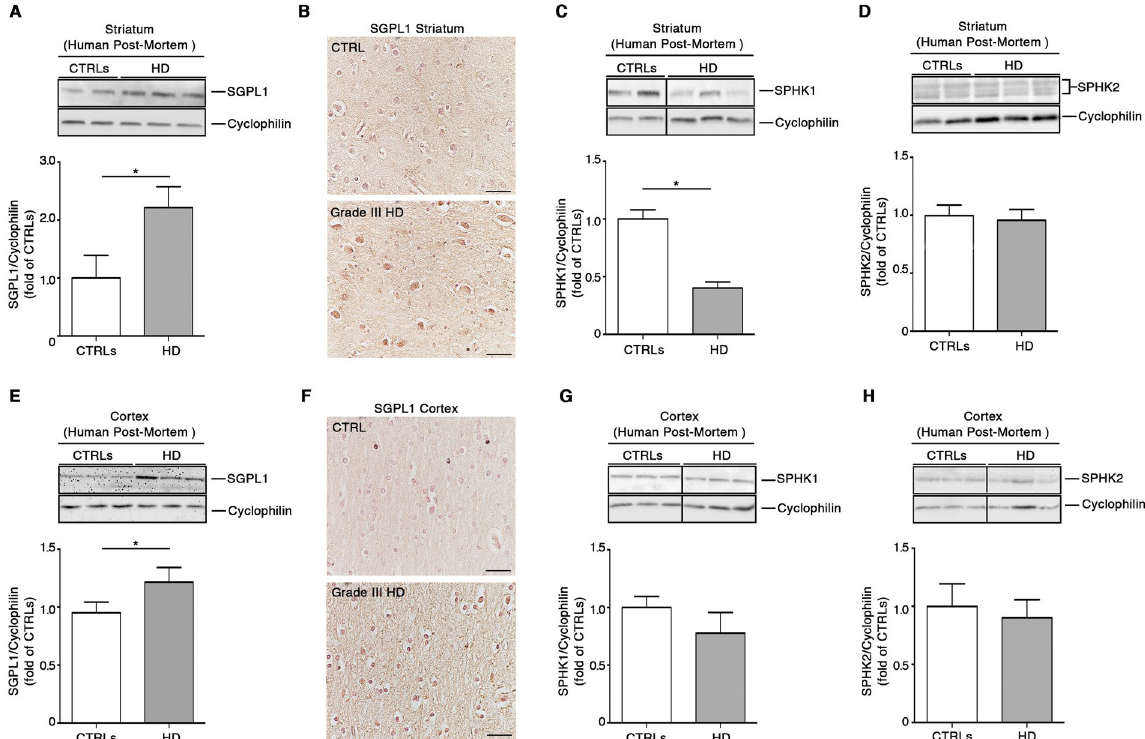
Figure 2. Expression of S1P metabolizing enzymes is abnormal in post-mortem brain tissues from HD patients. Cropped immunoblottings and densitometric analysis ( A ) along with representative immunohistochemical micrographs ( B ) of SGPL1 expression in the striatum from post-mortem human brains of manifest HD patients and age- and gender-matched healthy controls (see Table 1). Cropped immunoblottings and densitometric analysis of SPHK1( C ) and SPHK2 isoform expression ( D ) in the striatum from post-mortem human brains of the same subjects. Cropped immunoblottings and densitometric analysis ( E ) along with representative immunohistochemical micrographs ( F ) of SGPL1 in the cortex from human post-mortem brains of manifest HD patients and age- and gender-matched healthy controls. Cropped immunoblottings and densitometric analysis of SPHK1( G ) and SPHK2 isoform expression ( H ) in the cortex from post-mortem human brains of the same subjects. Scale bar in each micrograph represents 100 µ m. In each immunoblotting, all samples were run on the same gel. Non-adjacent samples were separated by a black line. Values are mean ± SD. N = 2–3 for each group of patients. * p < 0.05 (Unpaired